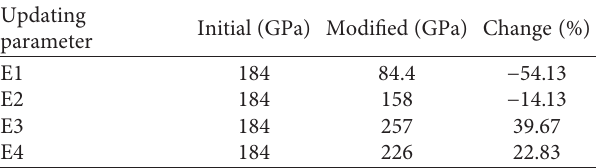
Table 10: Comparison of initial and updated parameters. Updating